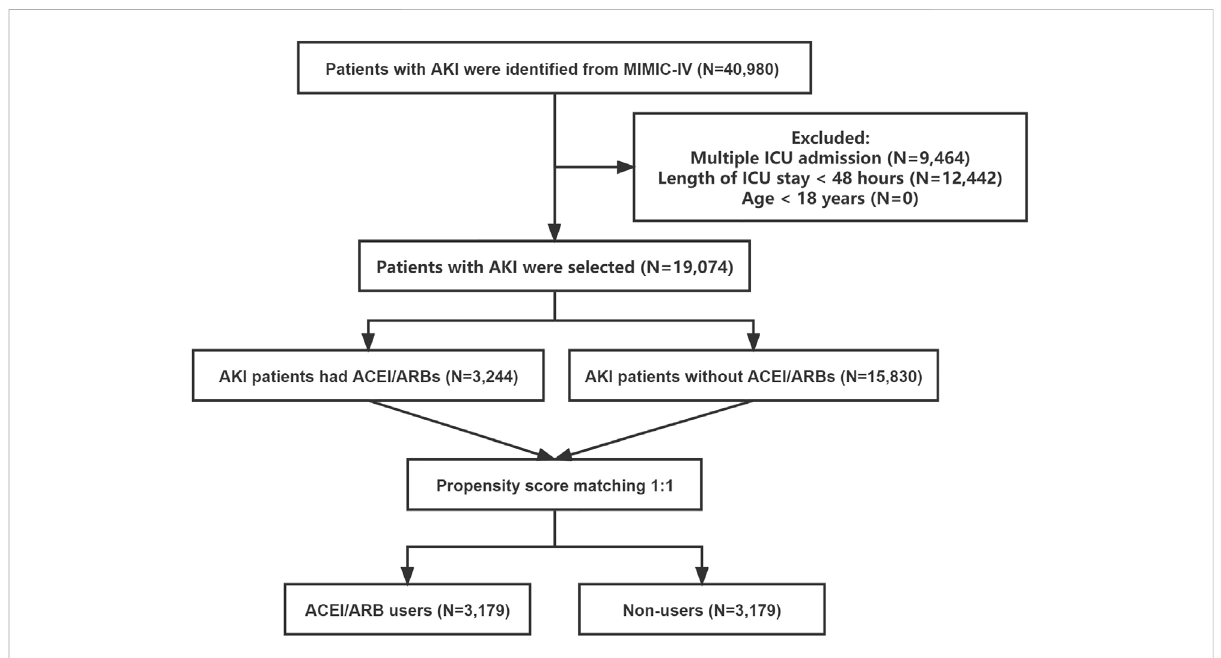
FIGURE 1 The fl owchart of patient selection. Abbreviations: AKI, acute kidney injury; ICU, intensive care unit; ACEI, angiotensin-converting enzyme inhibitor; ARB, angiotensin receptor blocker; MIMIC-IV, the Medical Information Mart for Intensive Care